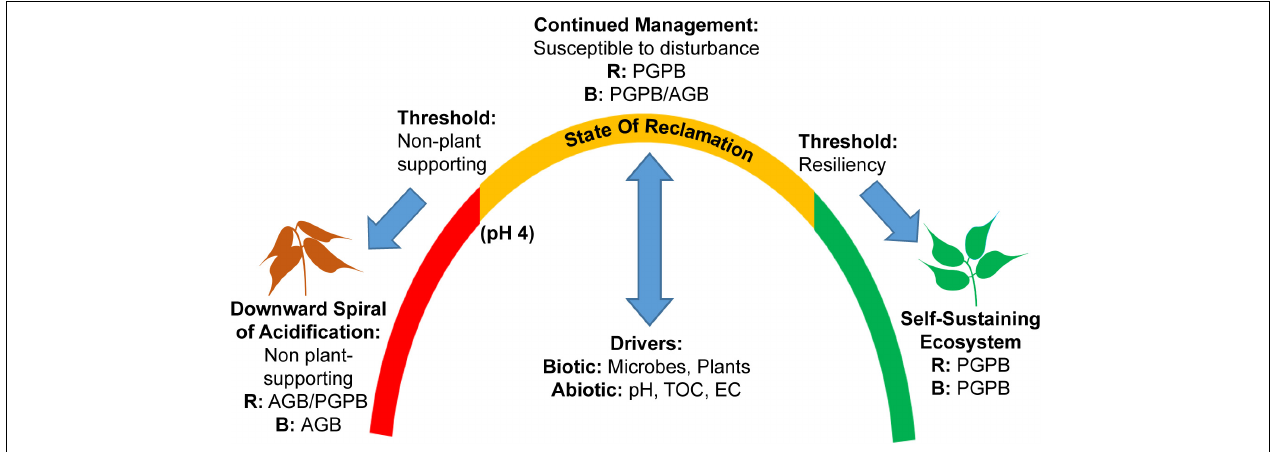
FIGURE 6 | Conceptual model depicting states of reclamation in terms of presence of plant-growth-promoting (i.e., N 2 -fixing) and acid-generating (i.e., Fe/S cycling) bacteria in the bulk and rhizosphere. AGB, acid-generating bacteria; PGPB, plant-growth-promoting bacteria; B, bulk; R, rhizosphere; TOC, total organic carbon.